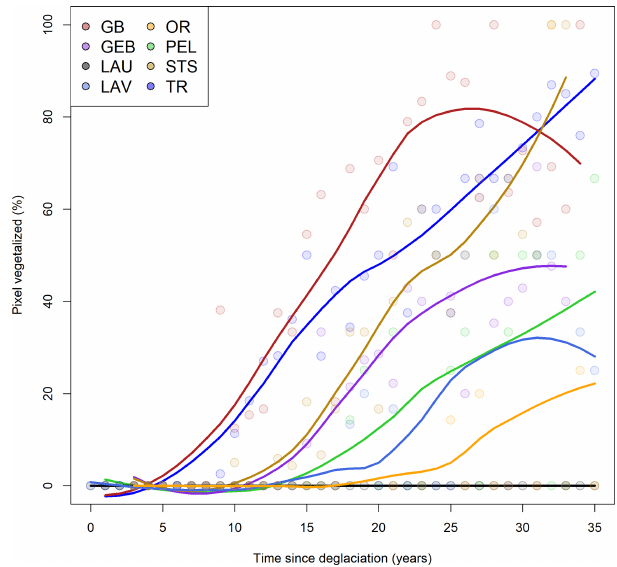
Figure 5. Proportion of pixels identified as vegetated according to time since deglaciation for all pixels within the eight glacier fore- fields. Trend lines are computed from a LOESS function with a span of